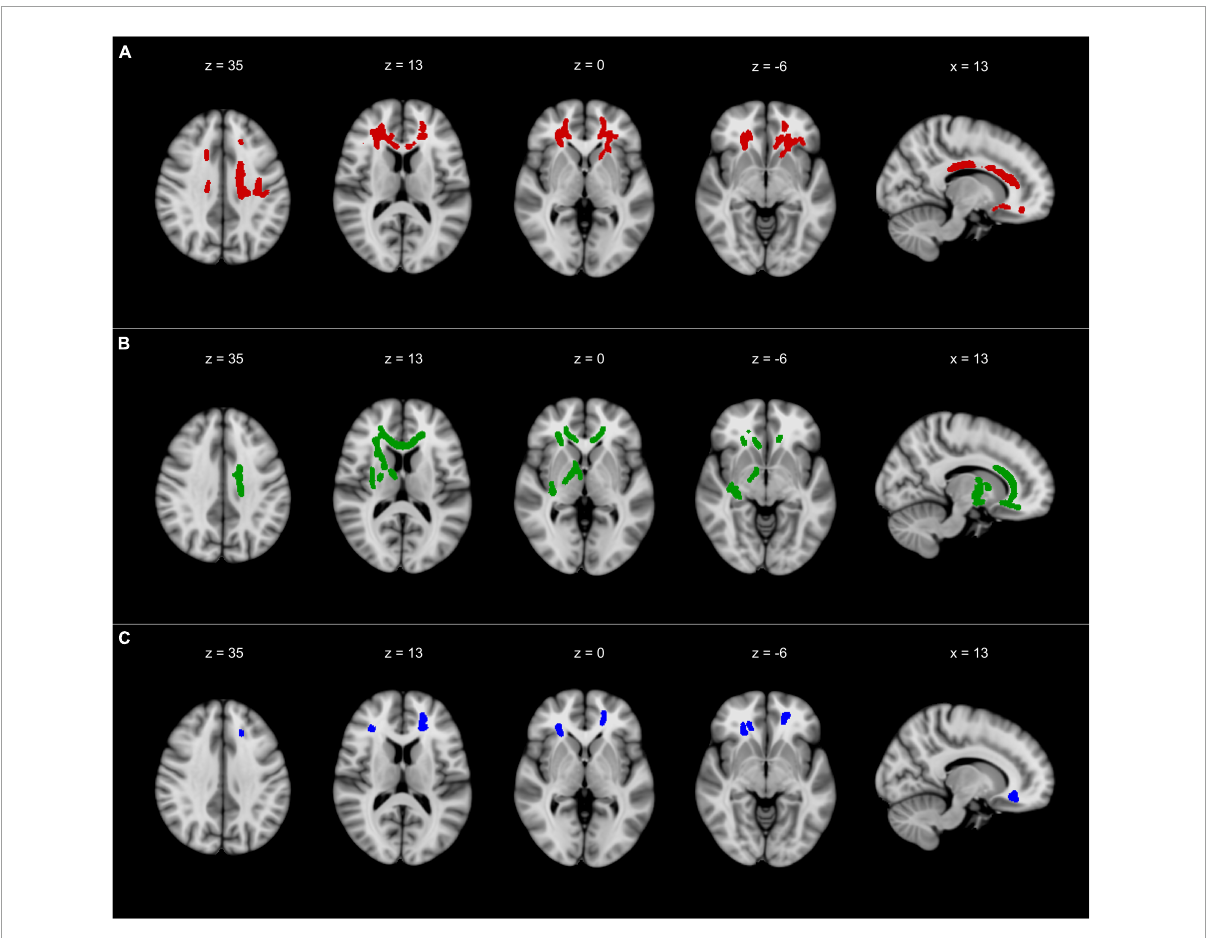
FIGURE1 The results of TBSS whole-brain correlation analysis overlaid on MNI-152 T1 (1 mm) template and presented in radiological convention. (A) Negative correlation between FA and DTC of gait speed while subtracting. (B) Positive correlation between FA and DT gait speed while subtracting. (C) Positive correlation between FA and DT subtracting speed while walking. All TBSS results were thickened to improve visualization and are presented with a threshold of p < 0.0125 corrected for multiple comparisons. TBSS, tract-based spatial statistics; FA, fractional anisotropy; DT, dual-task; DTC, dual-task costs; x, x-coordinate; z, z-coordinate. Detailed description of the significant clusters, including cluster sizes and correlation coefficients, can be found in Table 3